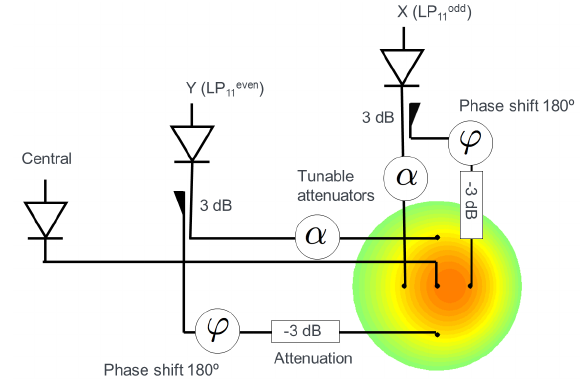
√ 2 compared to Fig. 3).